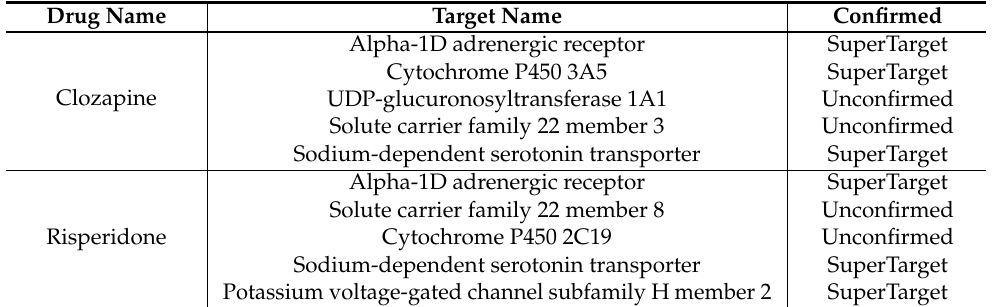
Table 5. New association prediction results for the top 5 targets with clozapine and